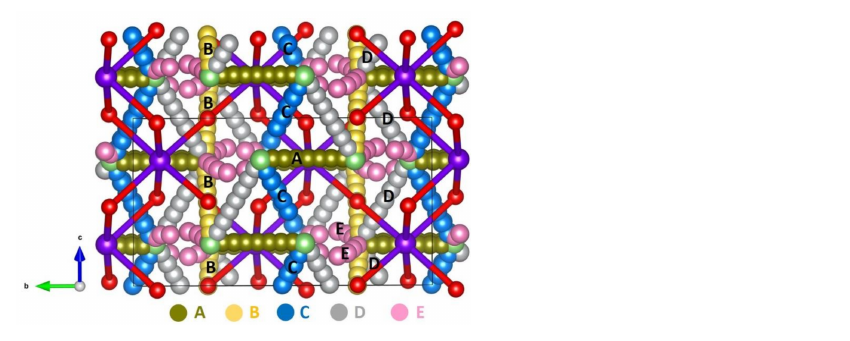
Figure 2. Li-ion diffusion pathways. Green, yellow, blue, grey and pink color atoms correspond to different Li